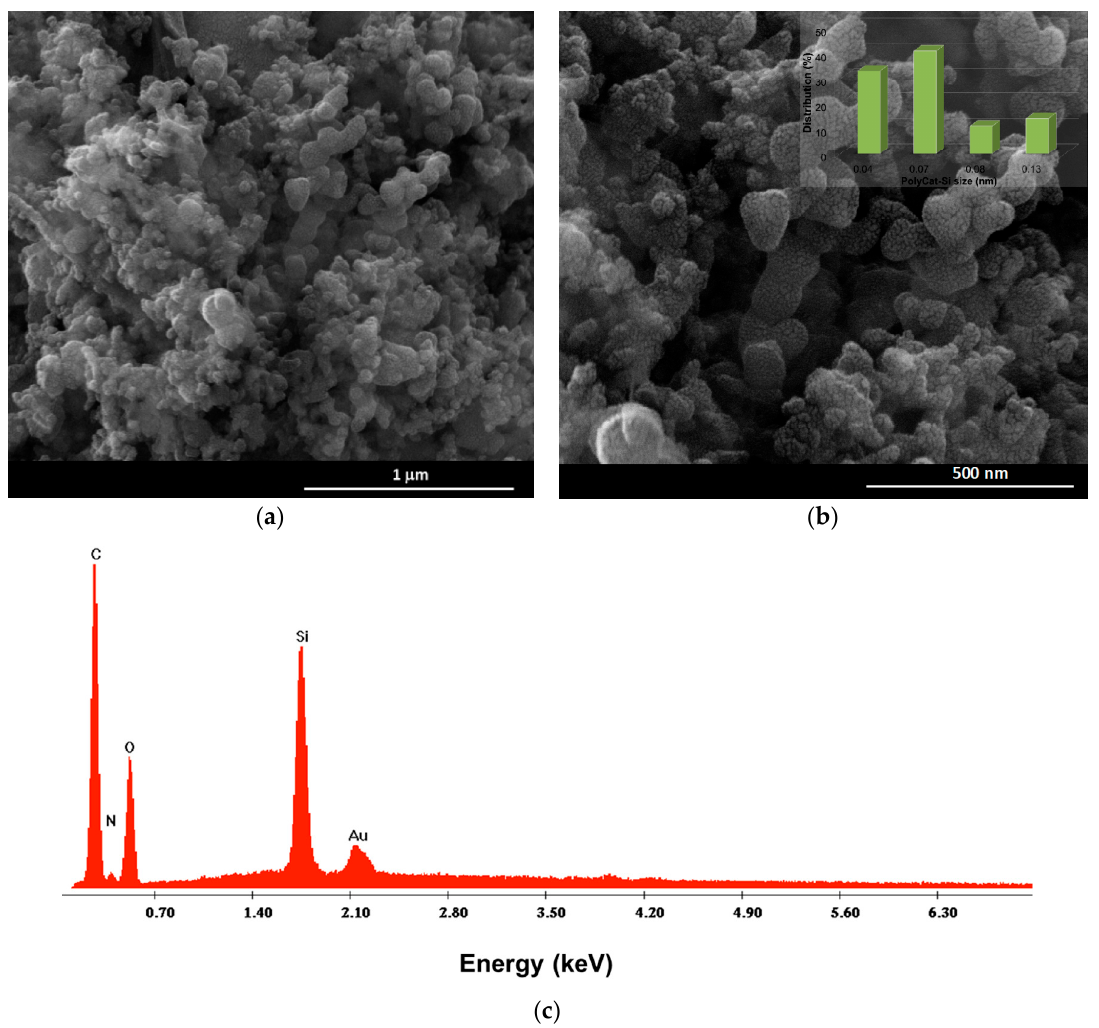
Figure 6. ( a , b ) SEM images of PolyCat-Si nanomaterial. The inset shows the PolyCat-Si size distribution (n =50); ( c ) EDS pattern. Sample is coated with gold.